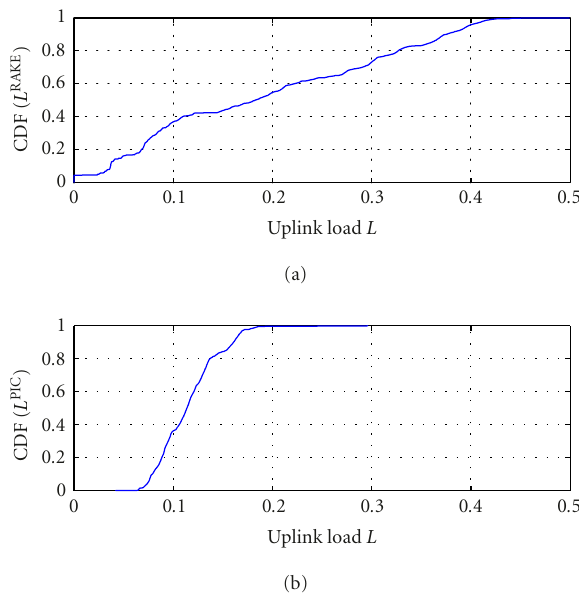
Figure 16: CDF comparison of the uplink load for (a) RAKE and (b)